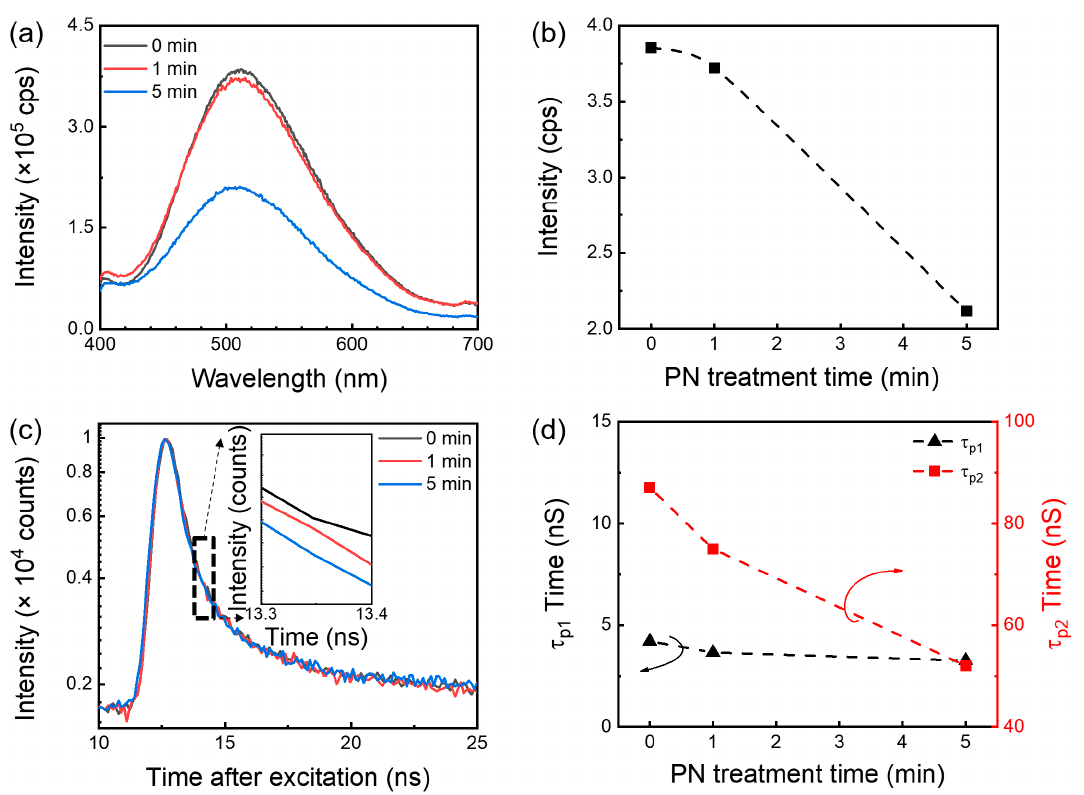
Figure 2. Room temperature PL ( a ) spectra and ( b ) peak intensity as a function of PN time. PL decay ( c ) profile (at 501 nm) and ( d ) time constant of β -Ga 2 O 3 at different PN treatment times. The arrows indicate each axis.